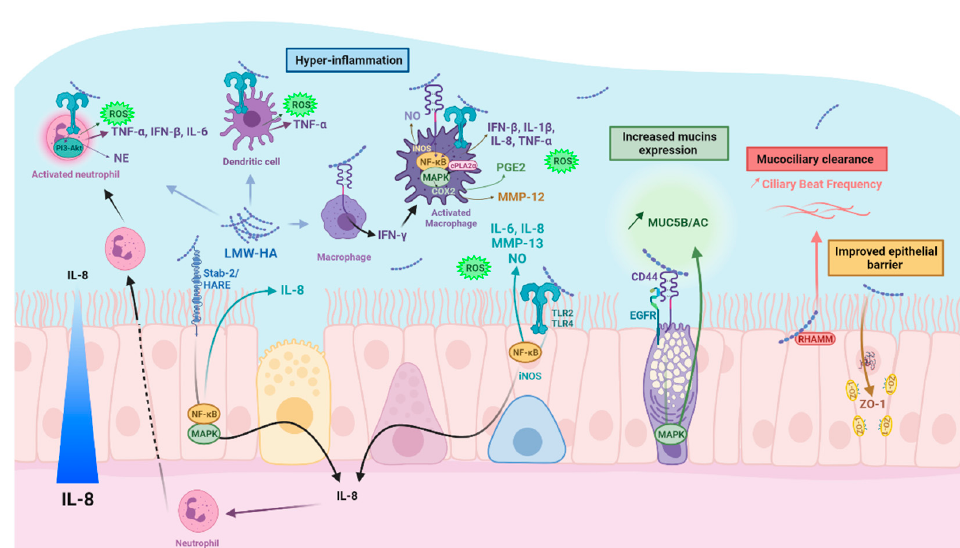
Figure 2. LMW-HA and lung hyaluronasome. LMW-HAs promote lung hyper-inflammation through hyaladherin interactions (CD44, TLR2, and TLR4, RHAMM, and HARE/Stab-2) and increase the secretion of cytokines (TNF- α , IFN- β , and IL-6), chemokines (IL-8), ROS, or enzymes (NE and MMPs). LMW-HAs also have beneficial impacts on the airway epithelium by increasing the CBF and by modulating intercellular junction protein expression. The dual functions of LMW-HAs maintain/amplify the lung inflammation while participating in the protection of the epithelium. Created with BioRender.com.